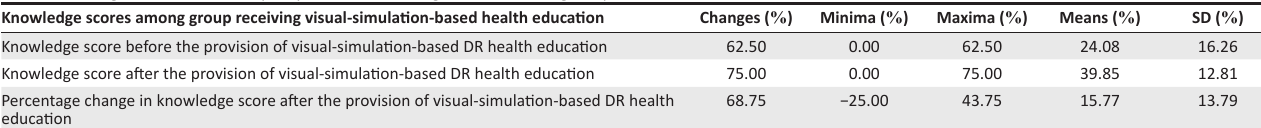
TABLE 4: Change in diabetic retinopathy related knowledge score following the provision of visual-simulation-based health education. Knowledge scores among group receiving visual-simulation-based health education Changes ( % )